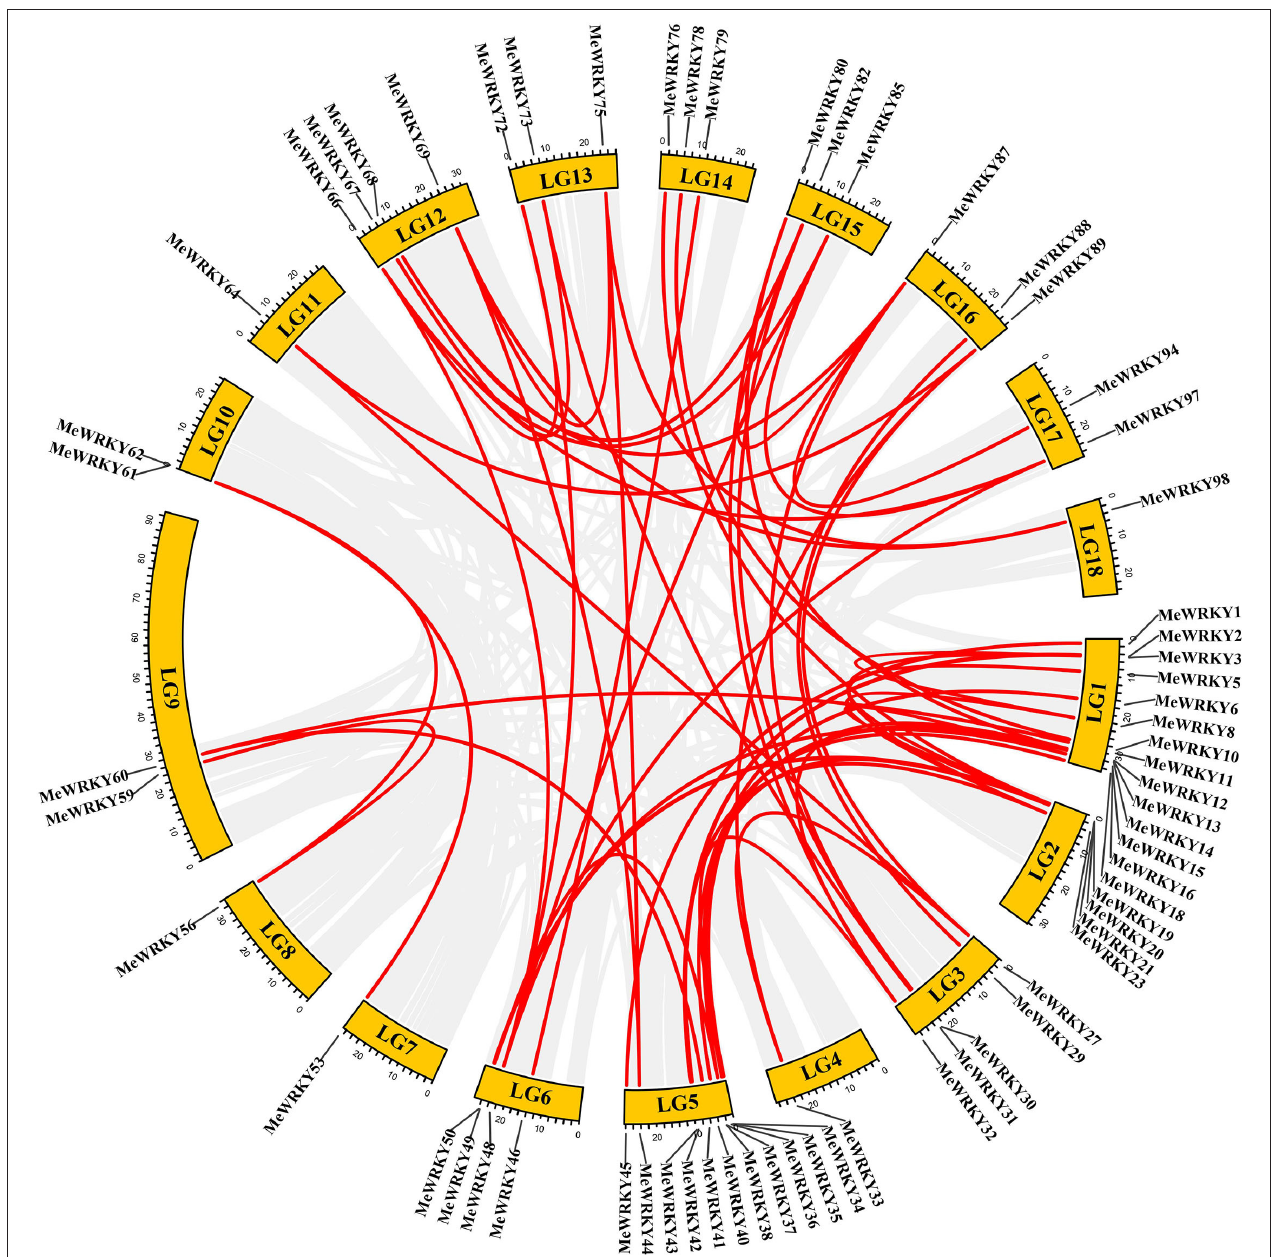
FIGURE 1 | Chromosomal distribution of duplicated MeWRKYs pairs generated by MCScanX. Gray lines represent synteny blocks in the cassava genome, and duplicated MeWRKY gene pairs are connected with red